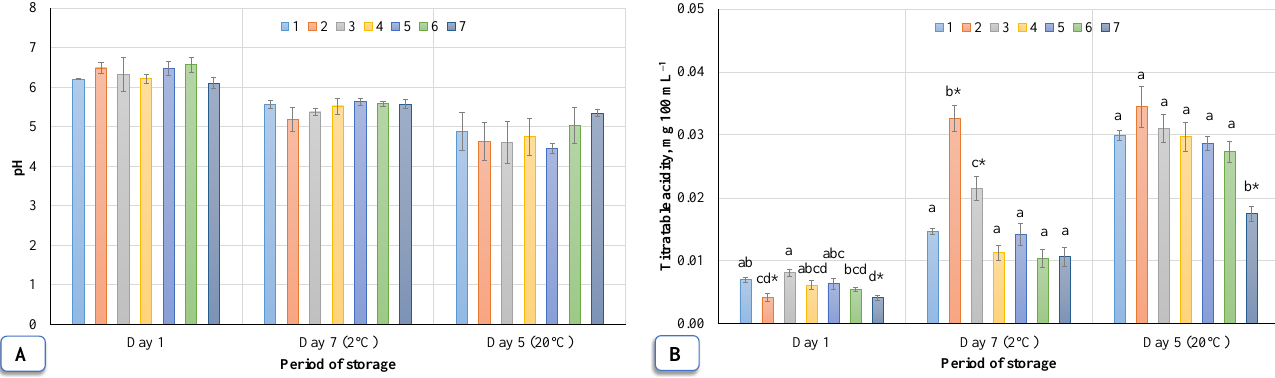
Figure 8. Variation of pH ( A ) and titratable acidity ( B ) of birch sap during storage: 1 (control) — non-ozonated sap (initial); 2 — sap ozonated for 5 min; 3 — sap ozonated for 10 min; 4 — sap ozonated for 15 min; 5 — sap ozonated for 20 min; 6 — sap ozonated for 25 min; 7 — sap ozonated for 30 min. Significant differences ( p < 0.05) were found according to a Tukey HSD test (marked in lowercase) and Dunnett tests (marked with an asterisk “*” ) ( n = 6).